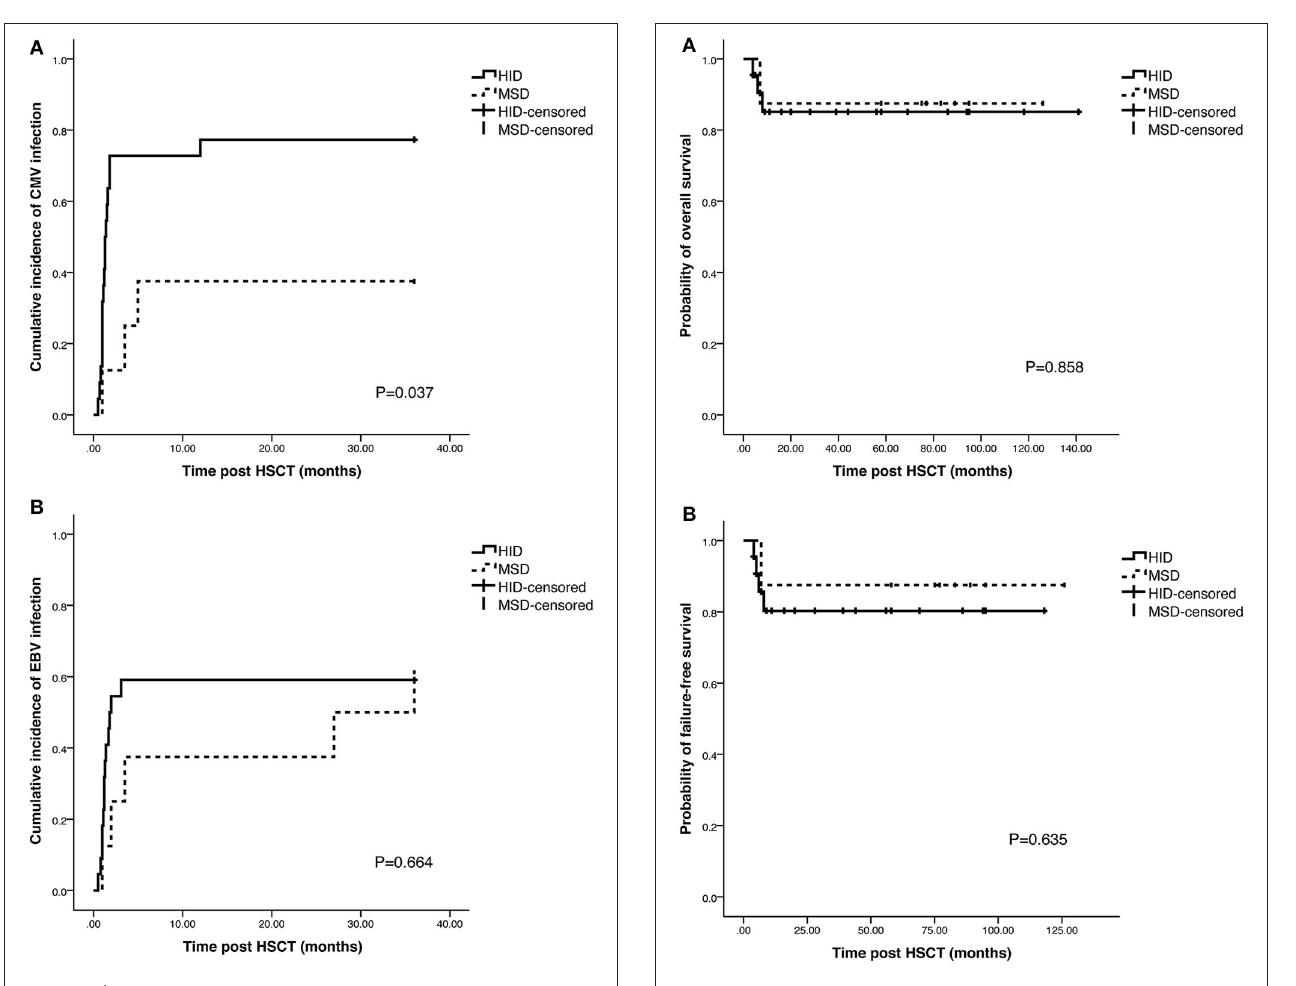
FIGURE 5 | Probability of overall survival and failure-free survival in HID and MSD cohort. (A) 5-year OS in HID and MSD cohort. (B) 5-year FFS in HID and MSD